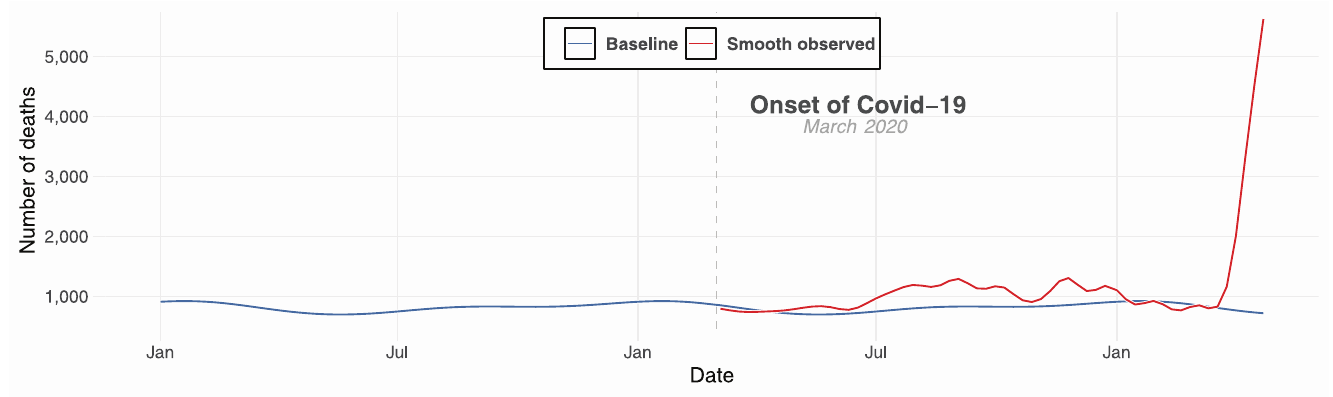
Fig 1. Model fit for weekly death counts. Model fit for weekly death counts amalgamated from multiple municipalities in Gujarat, India. The gray data points are weekly death counts, the dashed-vertical line represents the onset of Covid-19, the blue curve represents the expected weekly death counts based on historical data, and the red curve represents the smooth observed weekly death counts during